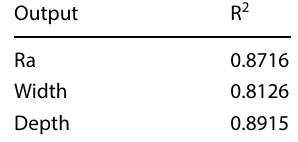
Table 2 The R 2 value